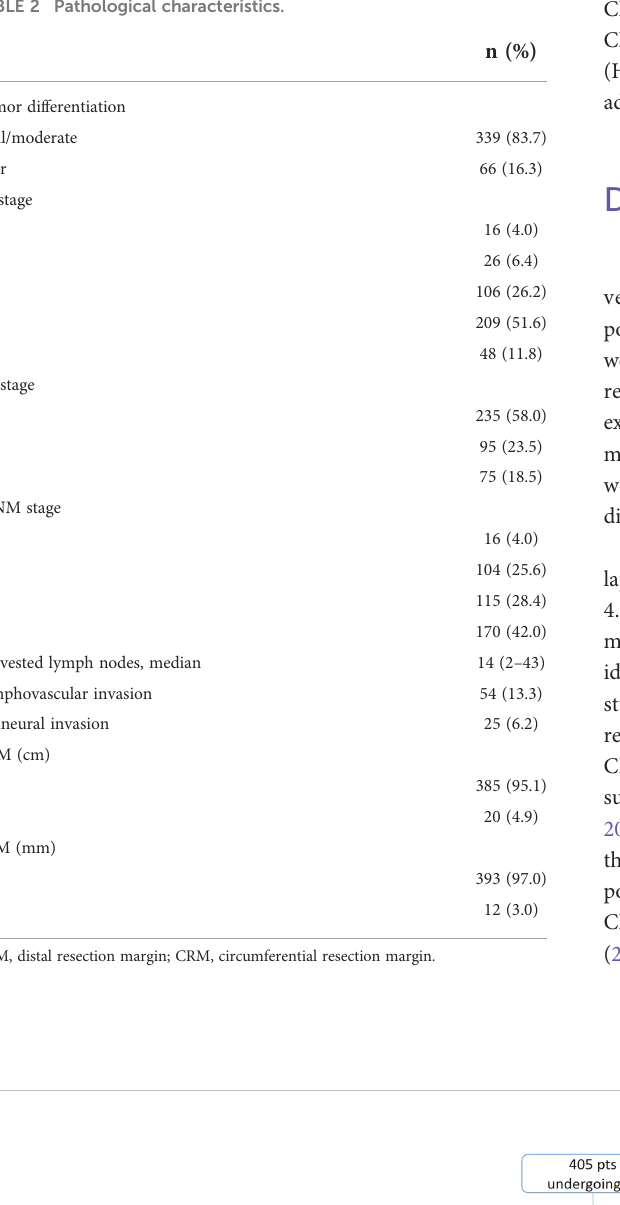
TABLE 2 Pathological characteristics.